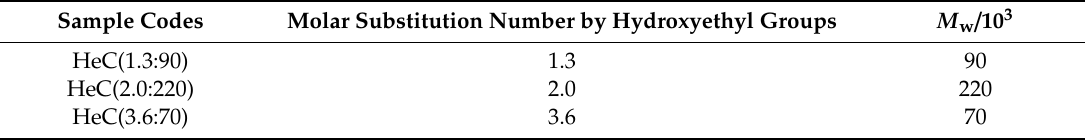
Table 1. Characteristics of hydroxyethyl cellulose, HeC, samples used in this study. Sample